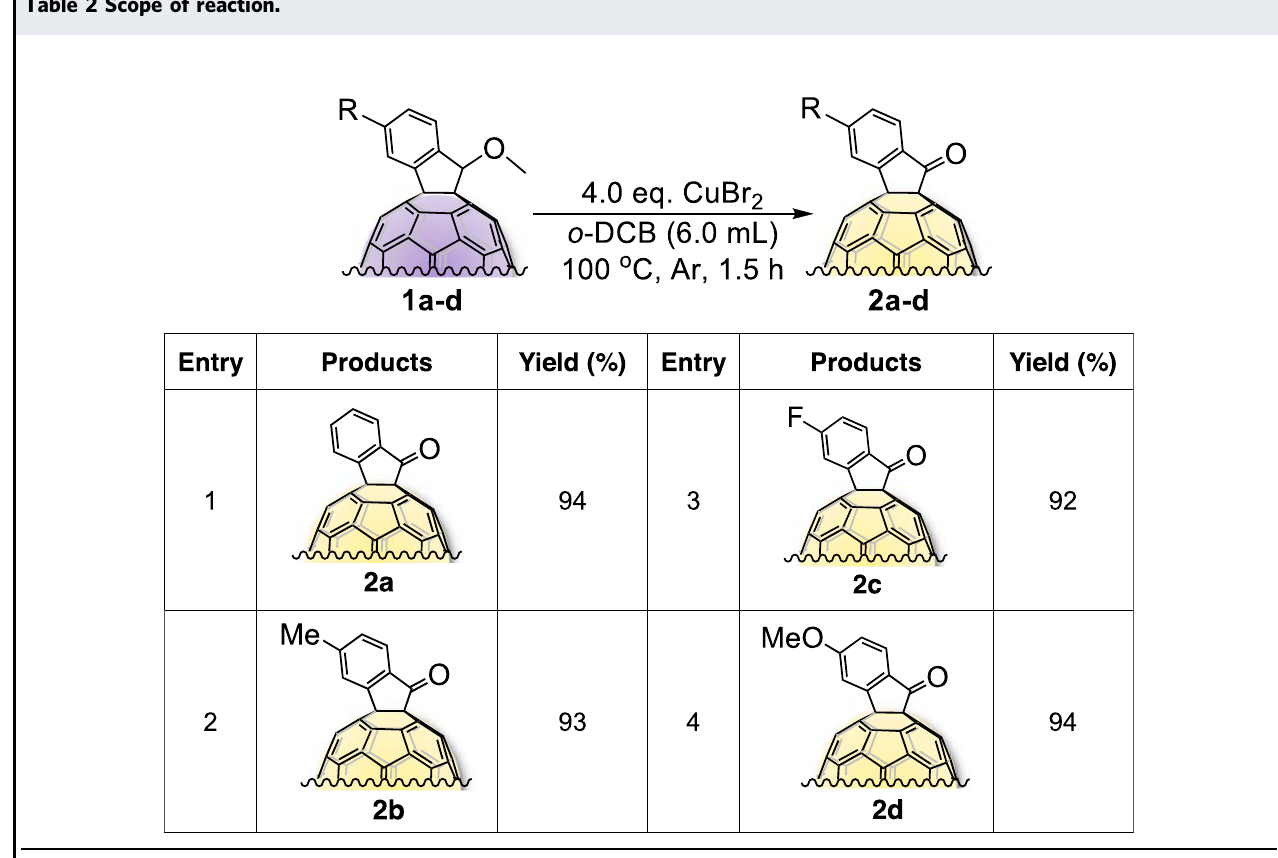
Table 2 Scope of